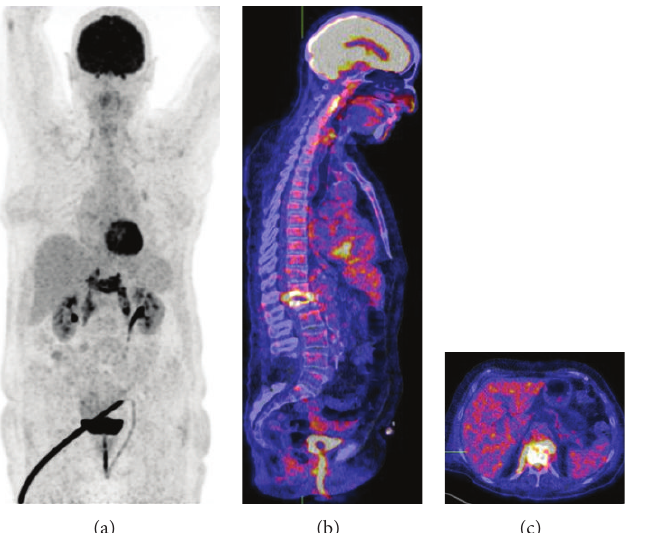
Figure 5: FDG-PET of a patient with spondylodiscitis and involvement of the psoas muscles. (a) Coronal MIP view, (b) fused PET/CT sagittal view, and (c) fused PET/CT transaxial